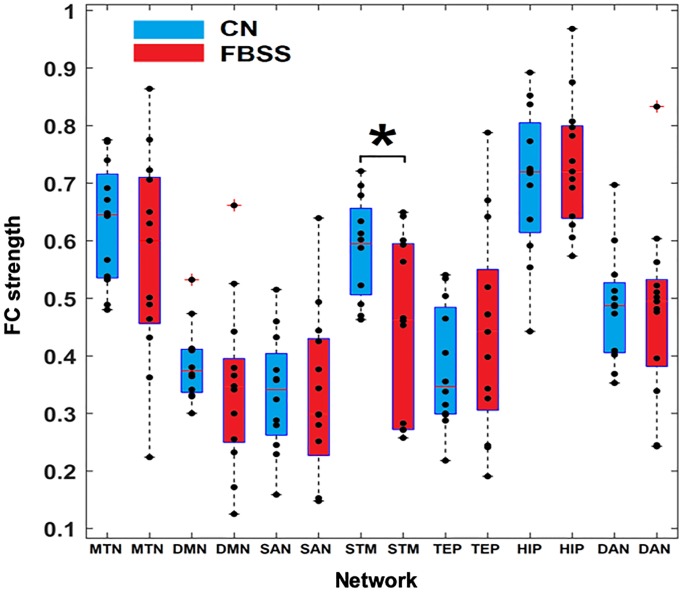
Functional connectivity (FC) within each network for control and FBSS groups.Box plots showing within network FC strength for control (CN, blue) and FBSS group (red) with individual overlaid data (black dots). Only the STM network shows significantly decreased within network FC (uncorrected) in FBSS group compared to CN group. * indicates p<0.05.